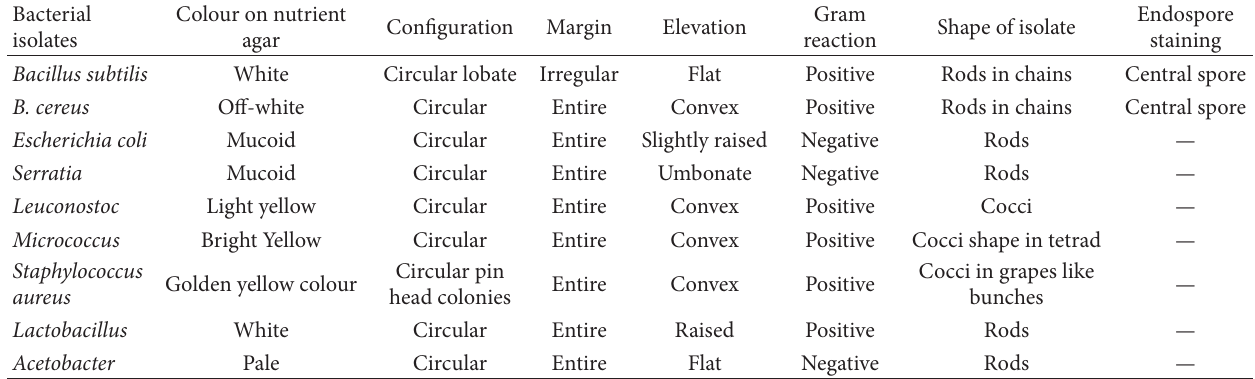
Table 2: Morphological characteristics of bacterial isolates of juices.